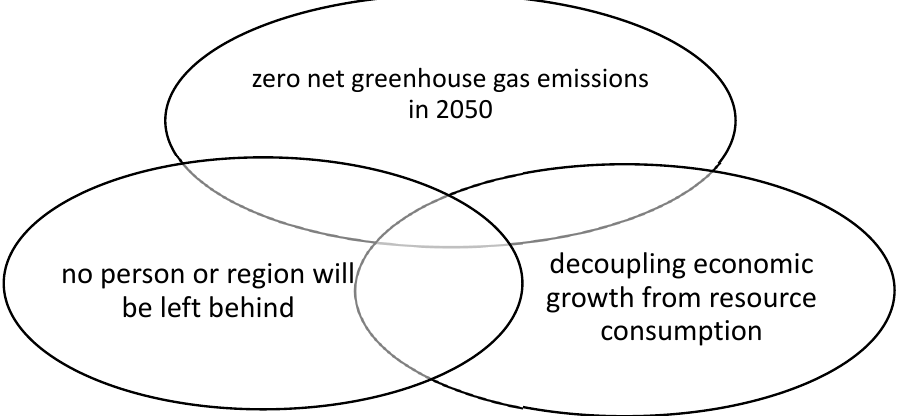
Figure 4. Assumptions of the European Green Deal. Source: [36] .